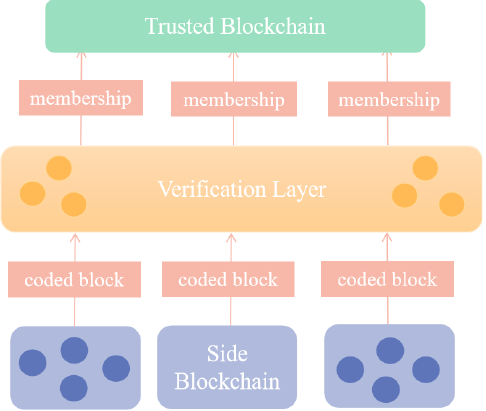
Figure 1. System